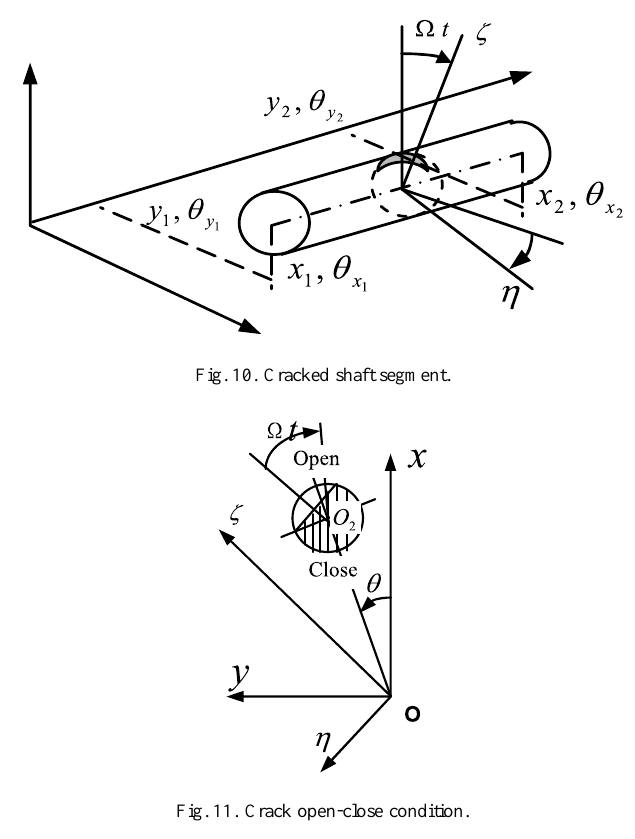
Fig. 11. Crack open-close